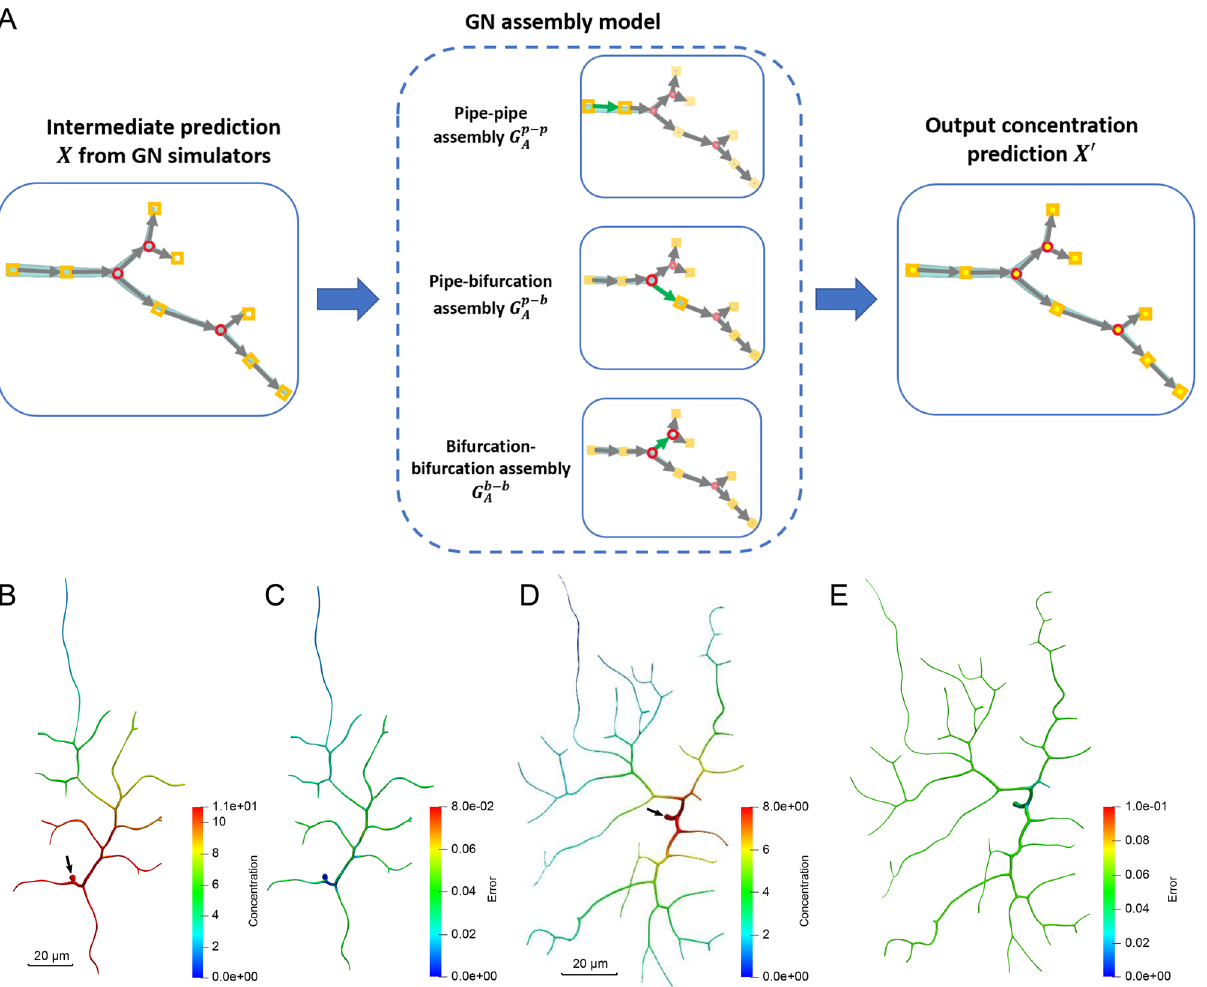
Figure 3. Results of the GNN assembly model. ( A ) The GNN assembly model takes the intermediate prediction X from individual GNN simulators as input and outputs the final concentration prediction X ′ . The GNN p − p G p − b G b − b assembly components G A , A and A adopt the “message-passing” scheme to aggregate the intermediate prediction from the neighboring nodes to update the concentration prediction. The green arrows show the message-passing process during the assembly. ( B , C ) The predicted concentration and the nodal prediction error of NMO_66731 at steady state ( t = 25 s ). ( D , E ) The predicted concentration and the nodal prediction error of NMO_66748 at steady state ( t = 31 s ). In ( B ) and ( D ), the black arrows point to the inlet of material. Scalar bar: 3 20 µ m . Unit for color bars: mol /µ m